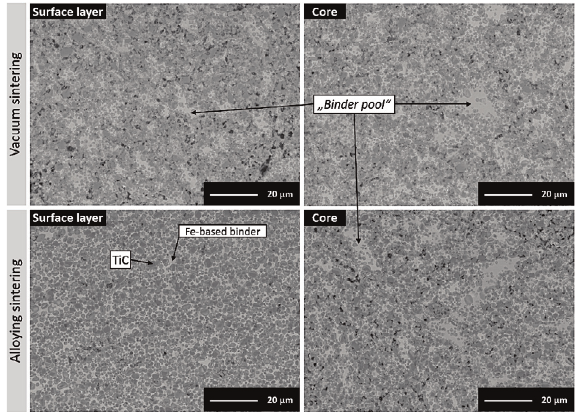
Fig. 3. The SEM images of microstructures of TiC-FeCr cermet after vacuum sintering (top) and alloying sintering in Mn micro - atmosphere (bottom). Microstructures of the surface layer (left) and the core region (right) are presented.